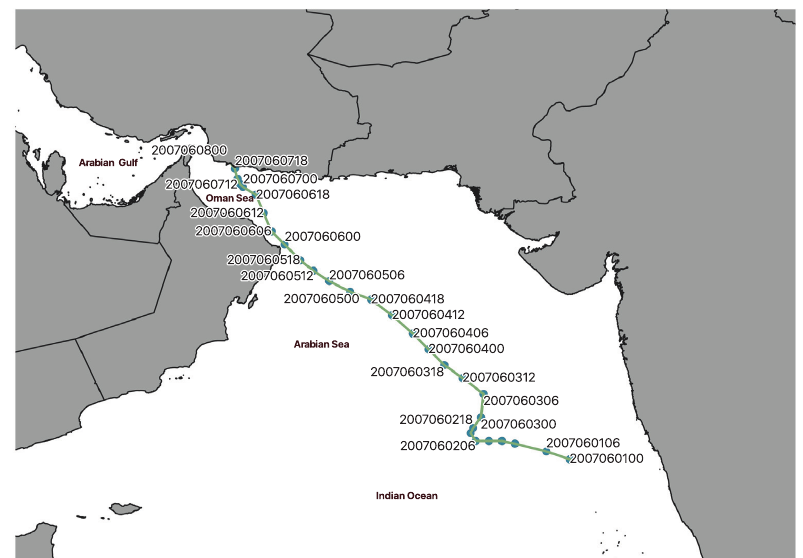
Figure 2: The best track of the TC “Gonu” (source: JTWC).